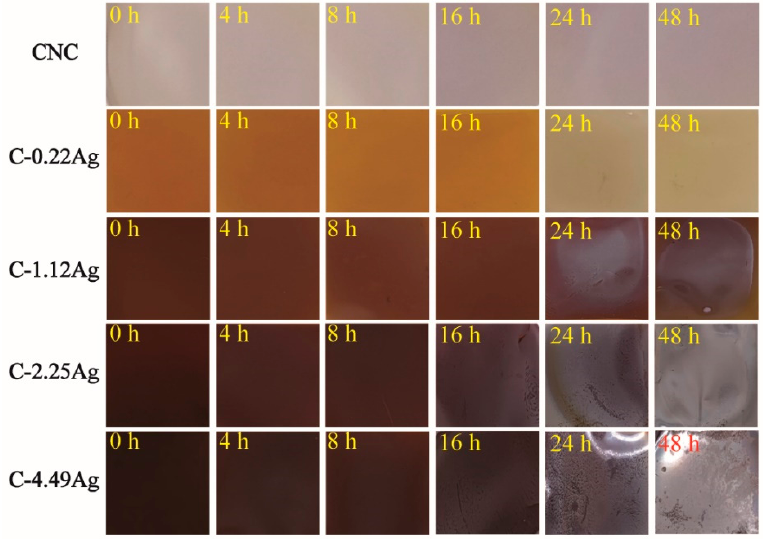
Figure 8. Photographs of neat CNC and CNC-AgNP films after contact with the chicken breast spoilage gas.